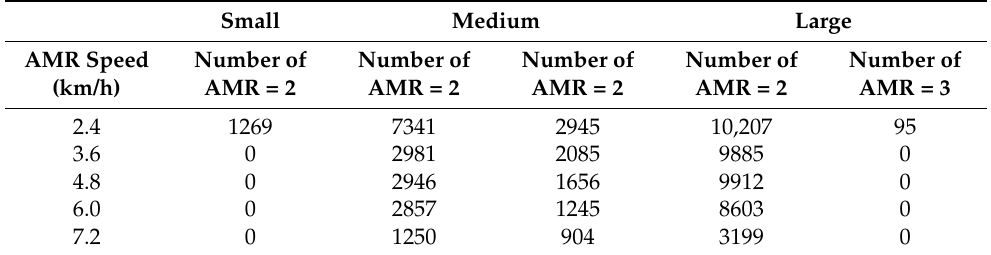
Table 2. Values of tardiness as a function of the AMR speed—shared handover locations. Small